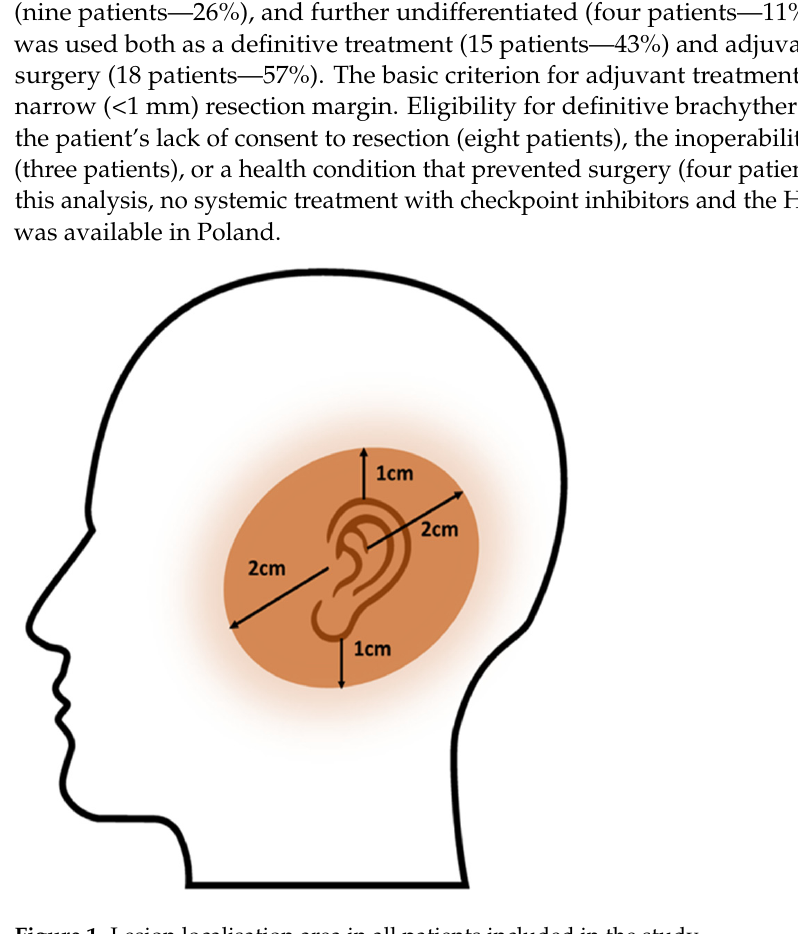
Figure 1. Lesion localisation area in all patients included in the study.